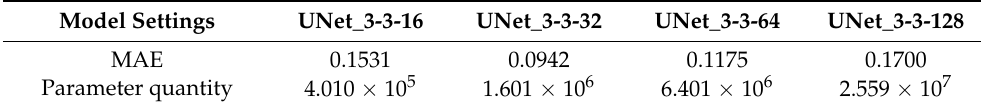
Table 4. Model performance comparison—number of convolutions.